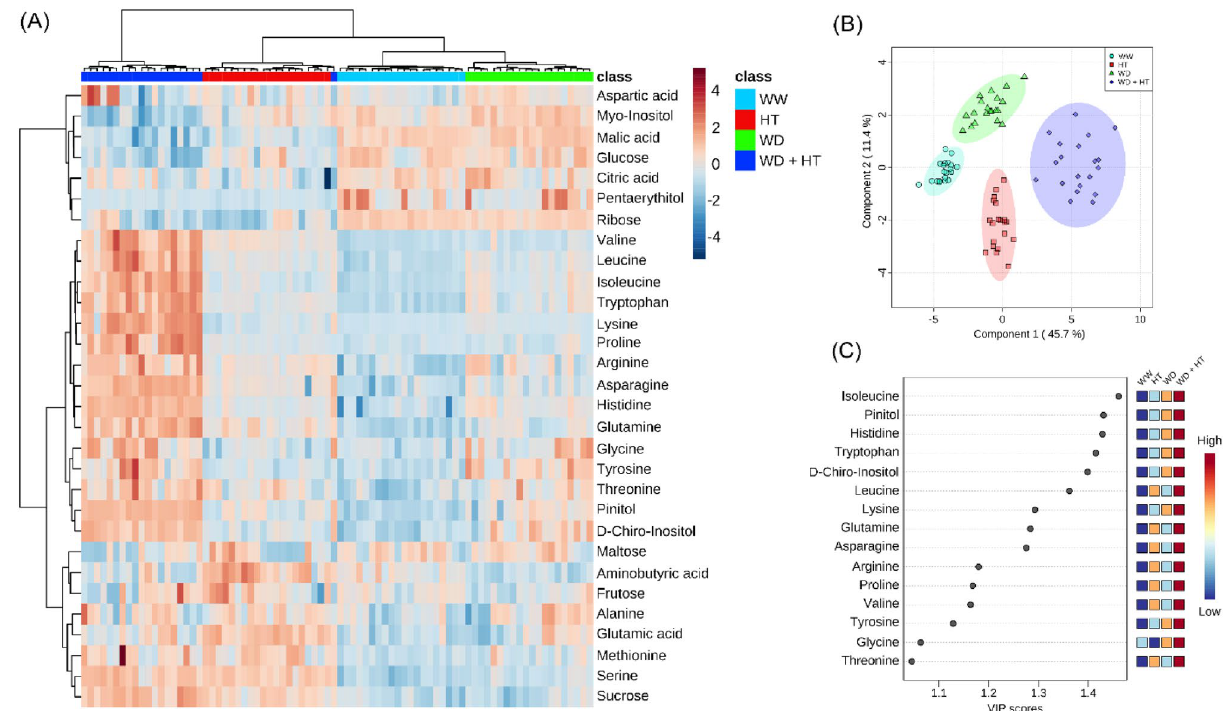
Figure 5. Metabolic characterization of soybean plants maintained for 8 days under well-watered (WW; 100% holding water capacity HWC, 25 °C), water deficit (WD; 40% HWC, 25 °C), high temperature (HT; 100% HWC, 40 °C) and water deficit plus high temperature (WD + HT; 40% HWC; 40 °C) conditions. ( A ) Heat map representation of the content of the metabolites identified in this study. ( B ) Partial least square-discriminant analysis (PLS-DA). ( C ) Variable importance in projection (VIP) scores of the PLS-DA model. Metabolites included in this VIP score list have score higher than 1, which indicates those that mostly contributed to the separation observed at the PLS-DA model. PLS-DA was carried out by combining data from all genotypes. The data were normalized by using Log and Auto-scaling transformations on the MetaboAnalyst platform 98 ( n =